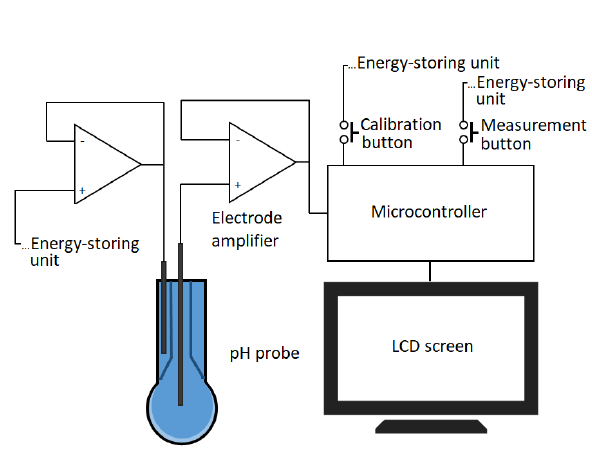
Figure 5. Detailed view of the pH